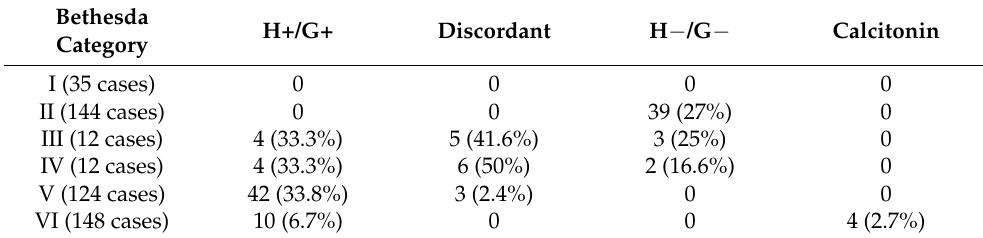
Table 7. ICC evaluation performed on 107 cases out of 475.